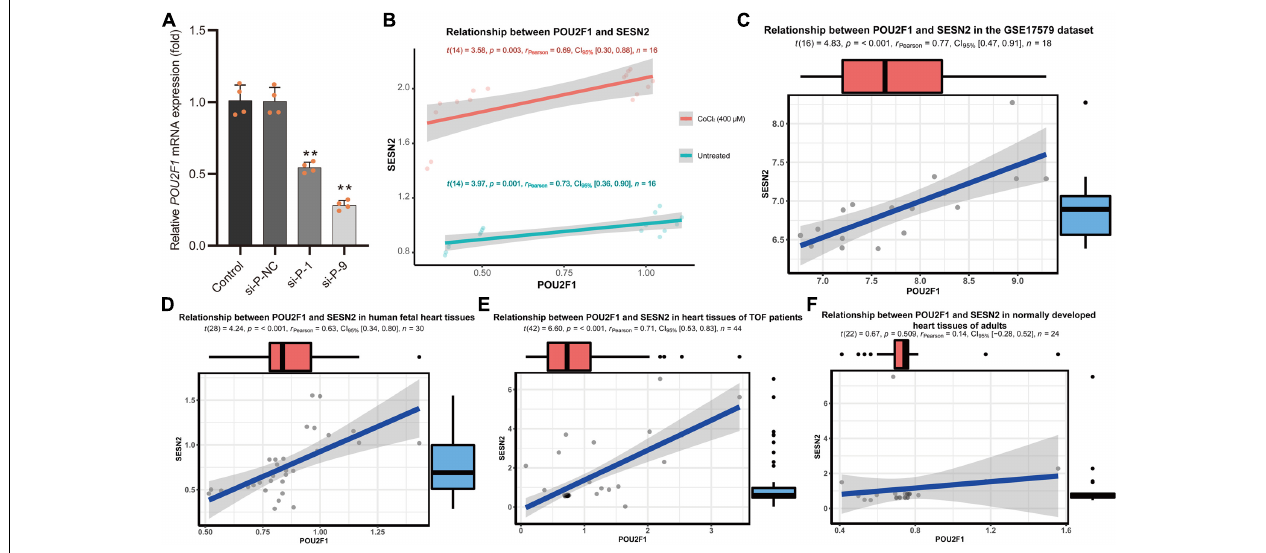
FIGURE 3 | Positive relationship between POU2F1 expression levels and SESN2 expression levels. (A) RNA interference targeting POU2F1 (si-P-1; 5 (cid:48) -GCAGGCUUUCCUUGGACAUTT-3 (cid:48) , and si-P-9; 5 (cid:48) -GGAAAUGACUUCAGCCAAATT-3 (cid:48) ) in HEK293T cells. ** P < 0.001 against negative control small interfering RNA (si-P-NC; 5 (cid:48) -UUCUUCGAACGUGUCACGUTT-3 (cid:48) ). (B) A positive relationship between POU2F1 expression and SESN2 expression was found either with or without hypoxia-mimetic CoCl 2 treatment in HEK293T cells. Red line refers to the case with 400 µ M CoCl 2 treated HEK293T cells (Pearson r = 0.69; P = 0.003) and green line refers to the case with untreated HEK293T cells (Pearson r = 0.73; P = 0.001). (C) Expression levels of SESN2 were positively correlated with POU2F1 expression levels in GSE17579 dataset (Pearson r = 0.77; P < 0.001). (D) Expression levels of SESN2 were positively correlated with POU2F1 expression levels in normal fetal heart tissues (Pearson r = 0.63; P < 0.001). The expression data were derived from GSE13834, GSE17579, GSE35776, GSE45821, GSE61154, and GSE150051. Expression profiles were normalized using R and LIMMA package, then the expression of β - ACTIN served as internal control to normalize the relative expression of SESN2 and POU2F1 . (E) Expression levels of SESN2 were positively correlated with POU2F1 expression levels in heart tissues of TOF patients (Pearson r = 0.63; P < 0.001). The expression data were derived from GSE14970, GSE26125, and GSE35776. Expression profiles were normalized using R and LIMMA package, then the expression of β - ACTIN served as internal control to normalize the relative expression of SESN2 and POU2F1 . (F) The significantly positive relationship between SESN2 expression and POU2F1 expression was not observed in normal adult heart tissues (Pearson r = 0.14; P = 0.509). The expression data were derived from GSE17579, GSE26125, GSE35776, and GSE45821. Expression profiles were normalized using R and LIMMA package, then the expression of β - ACTIN served as internal control to normalize the relative expression of SESN2 and POU2F1